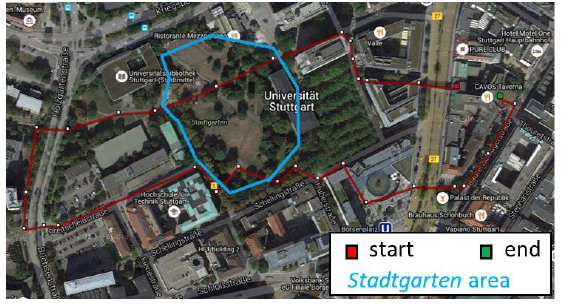
Figure 1. Map of path during the study